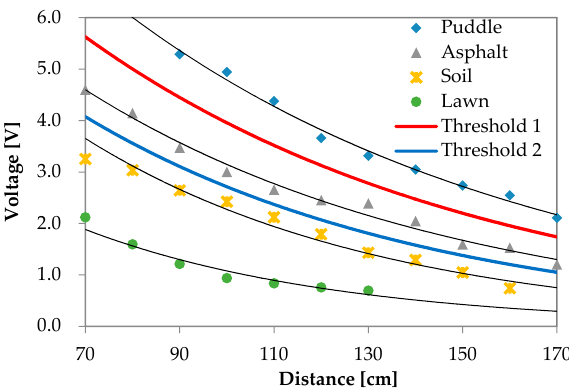
Figure 10. Experimental result showing the reflection intensities of all objects.